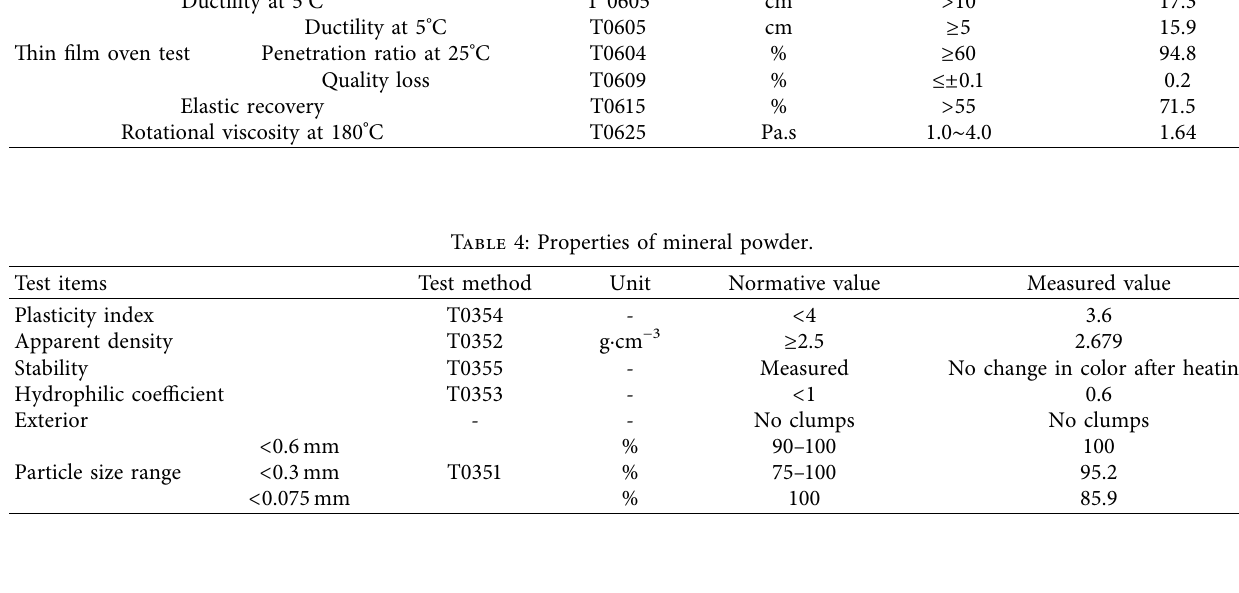
Table 5: Gradation